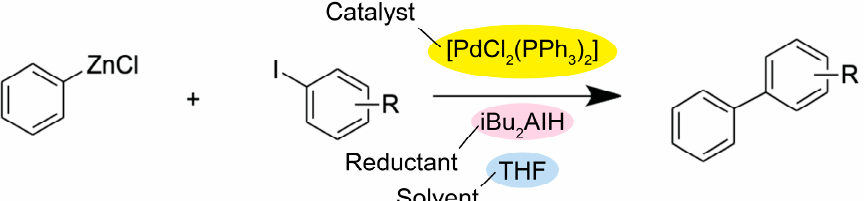
Figure 3. General reaction scheme for the Stille coupling reaction [25].